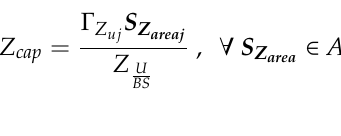
Table 2. 5G link budget parameters for mmWave at 28